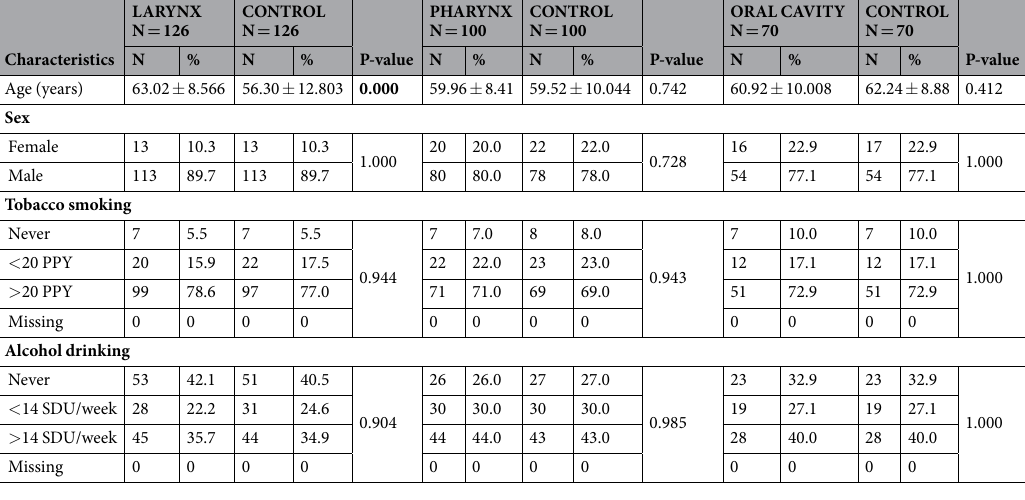
Table 4. Descriptive case-control study matched by the Propensity Score method. P-values related to controls. Statistically significant results in